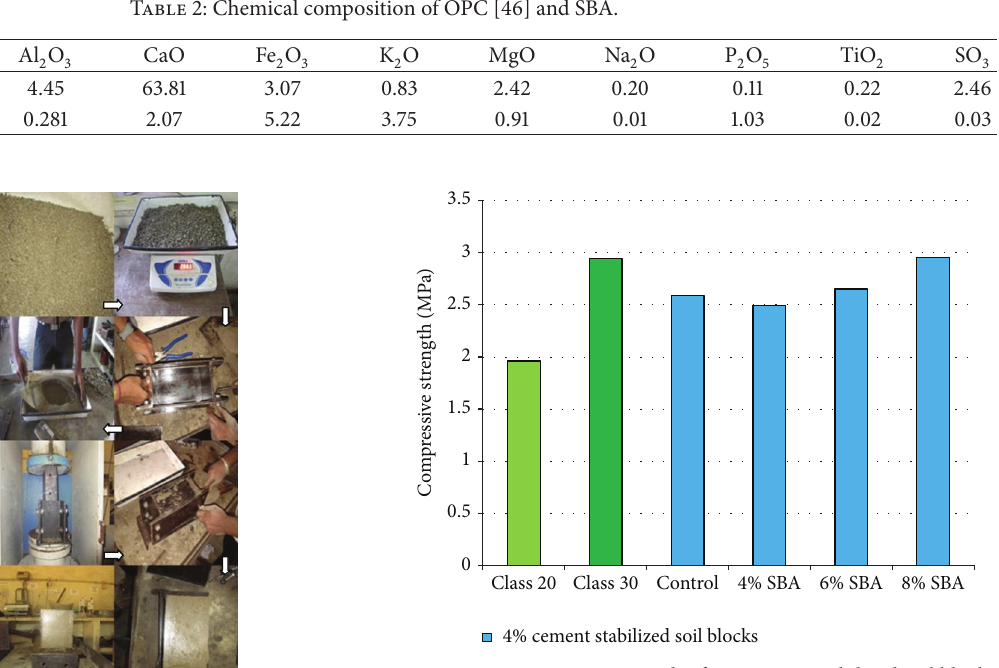
Figure 3: Compressive strength of 4% cement stabilized soil blocks admixed with